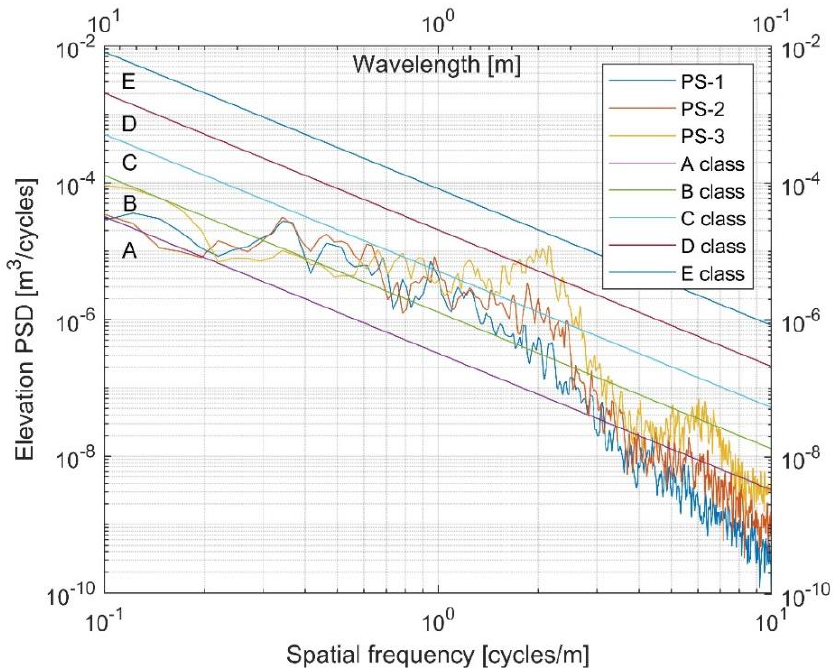
Figure 4. Roughness representation of the measured road section in its different states.